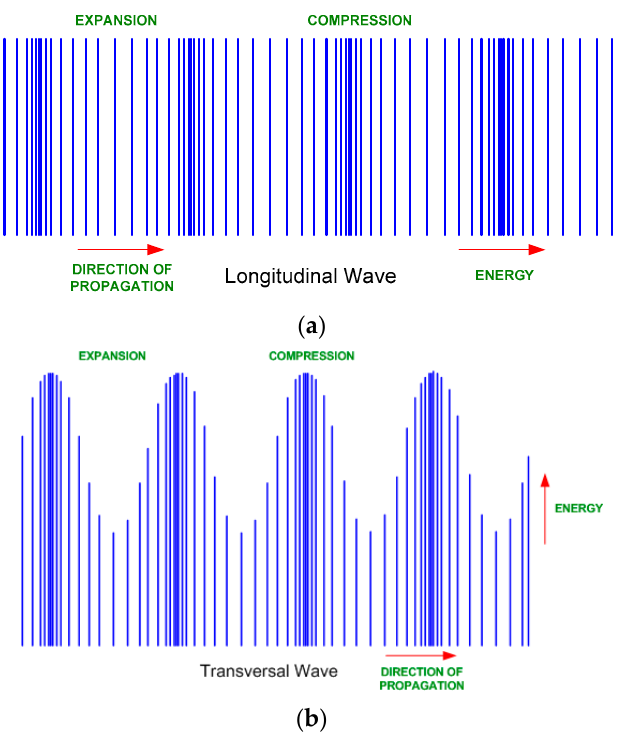
Figure 2. Acoustic waves. ( a ) Longitudinal acoustic wave. ( b ) Transverse acoustic wave.